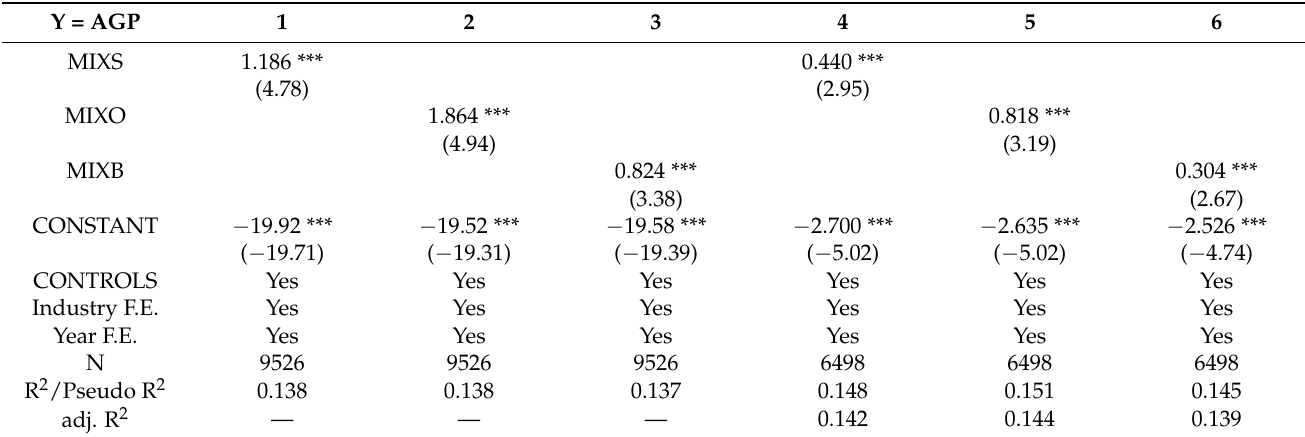
Table 8. Alternative empirical specifications and sample